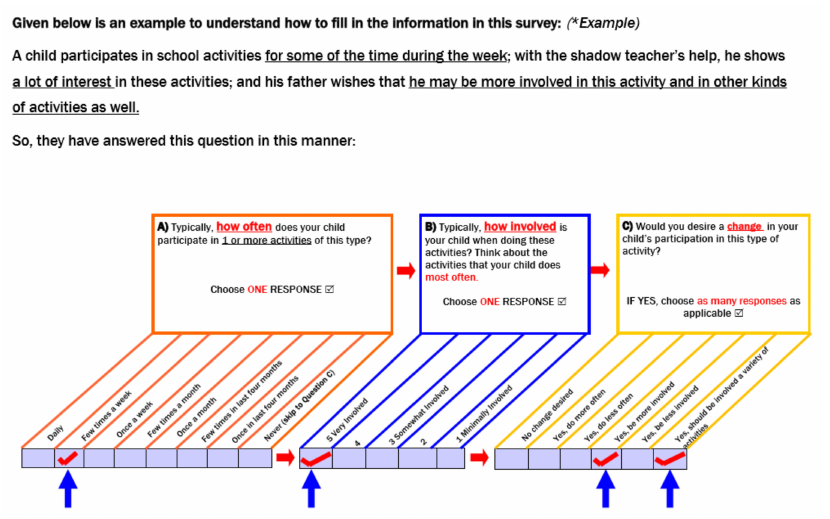
Figure 2. Clarifying survey instruction; ( A ), ( B ) and ( C ) subparts of the question on participation in a given setting elicit information about Frequency, Level of Involvement and Caregivers’ desire for change in frequency, involvement and variety of activities in which the child participates